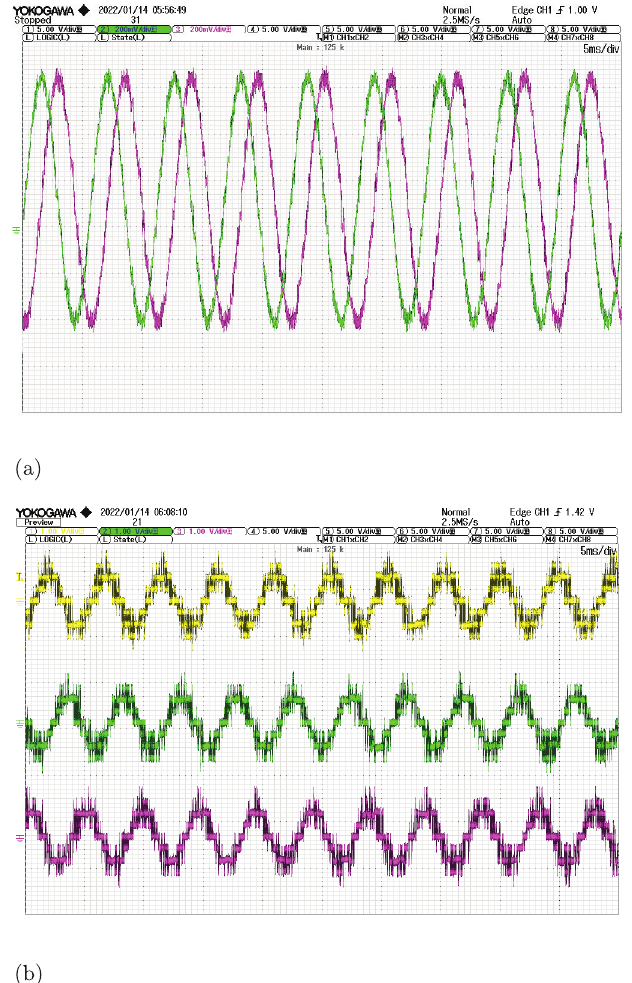
Figure 11. HIL results: ( a ) alpha and beta stator current components, ( b ) line to line output voltages.